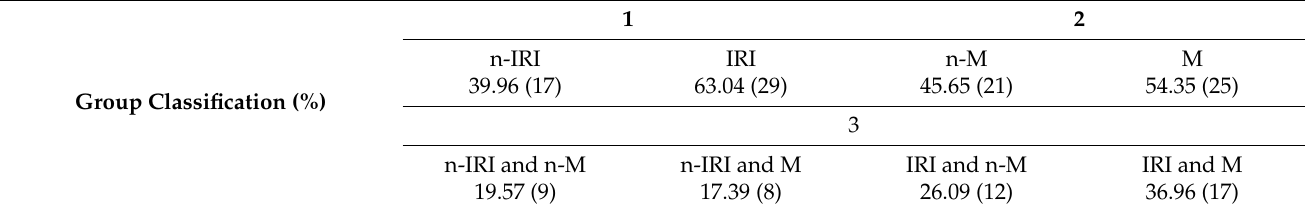
Table 4. Distribution of patients grouped by early post-perfusion injury and marginal organ and the respective combinations: classification of the pre- and post-transplant biopsies of 46 patients according to presence (IRI) or absence (nIRI) of early ischemia reperfusion damage (group 1), as well as receiving a marginal (M) or non-marginal (nM) organ (group 2). Group 3 shows the resulting combinations.